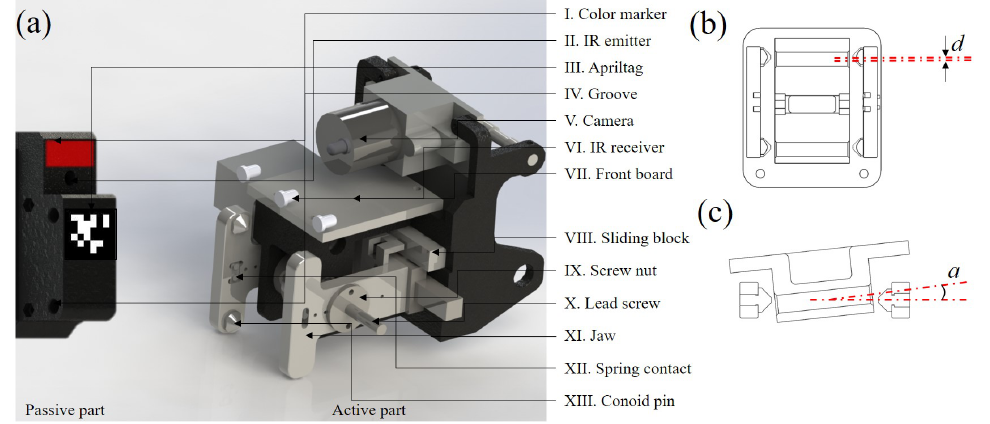
Figure 4. Docking mechanism and sensors for docking. ( a ) The passive part includes the grooves and the electrical contact socket. The color marker and Apriltag marker are used to indicate the position and orientation in different distances of the front robot module, as well as robot identifier (ID number). The IR emitter is used with the receiver of the active part to guide nearby docking. The active part integrates a pair of opposing jaws, driven by a bidirectional lead screw and nut mechanism. The camera can recognize the markers and provide the coordinate and ID information. ( b ) Displacement distance d between the pin and groove axis from the front view. ( c ) Angular displacement a between the pin and groove axis from the top